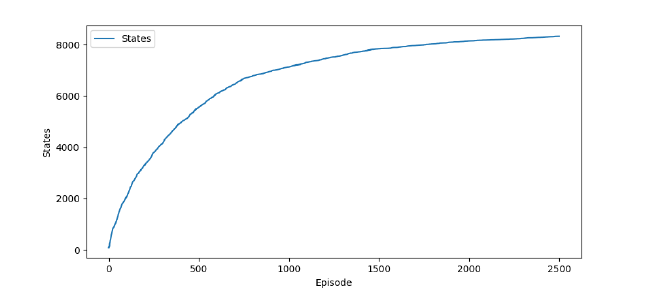
Figure 5. Total number of states during training.